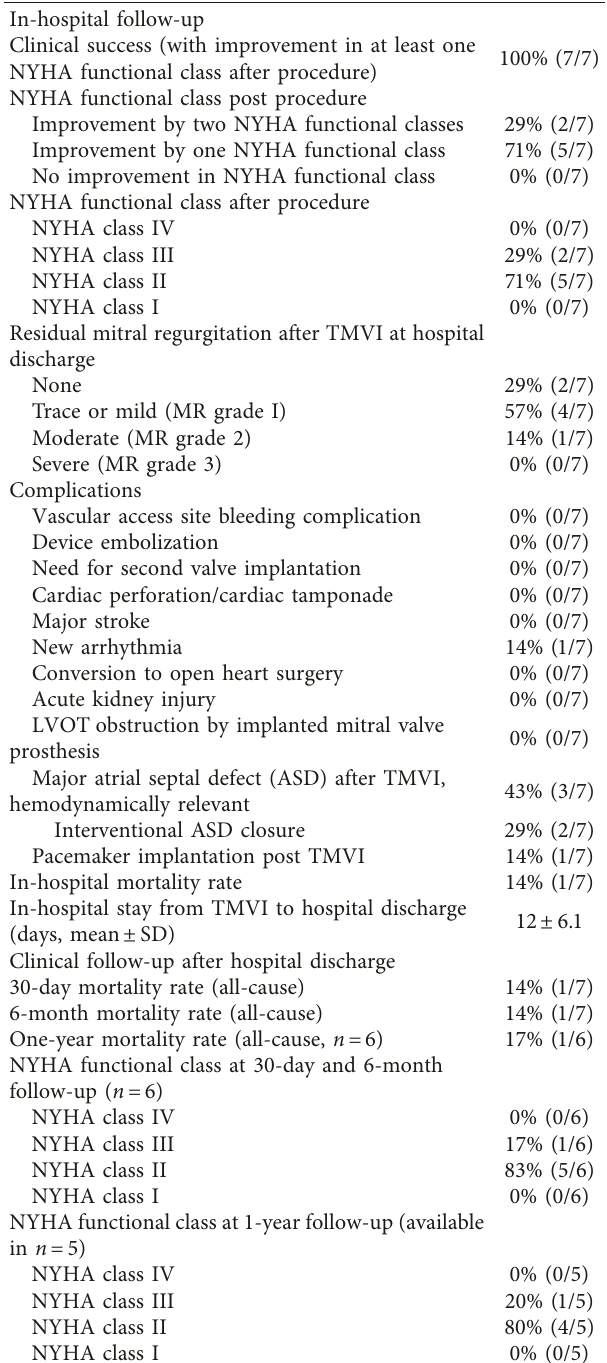
Table 3: Clinical outcome (in-hospital, 30-day-, 6-month- and one-year follow-up).